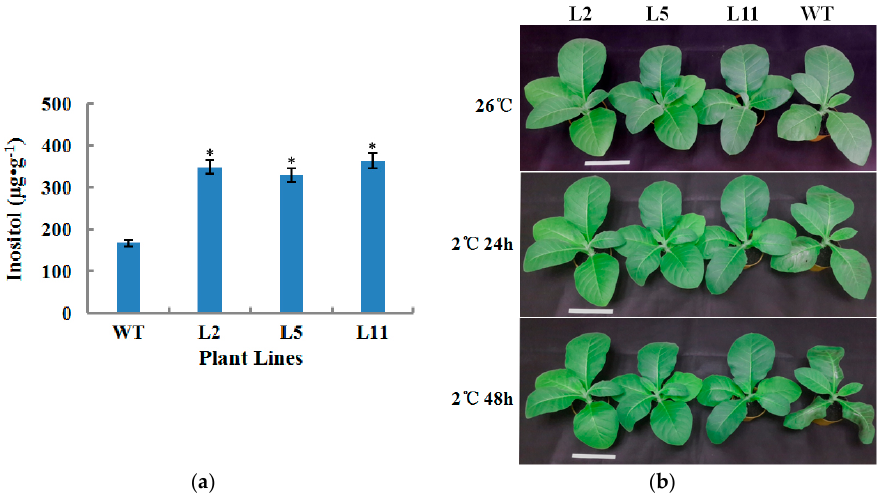
Figure 4. OsIMP transgenic lines exhibit improved cold tolerance. ( a ) Measurement of inositol in the leaf of wild type (WT) and OsIMP over-expression lines (L2, L5 and L11). Data are the mean ± SE of three biological replicates; asterisks indicate significant differences (* p < 0.05, ** p < 0.01) in comparison with wild type. ( b ) Phenotypes of seedlings of WT and transgenic tobacco plants (L2, L5 and L11) exposed to cold stress condition (2 °C) for 48 h. The scale bar represents 10 cm.